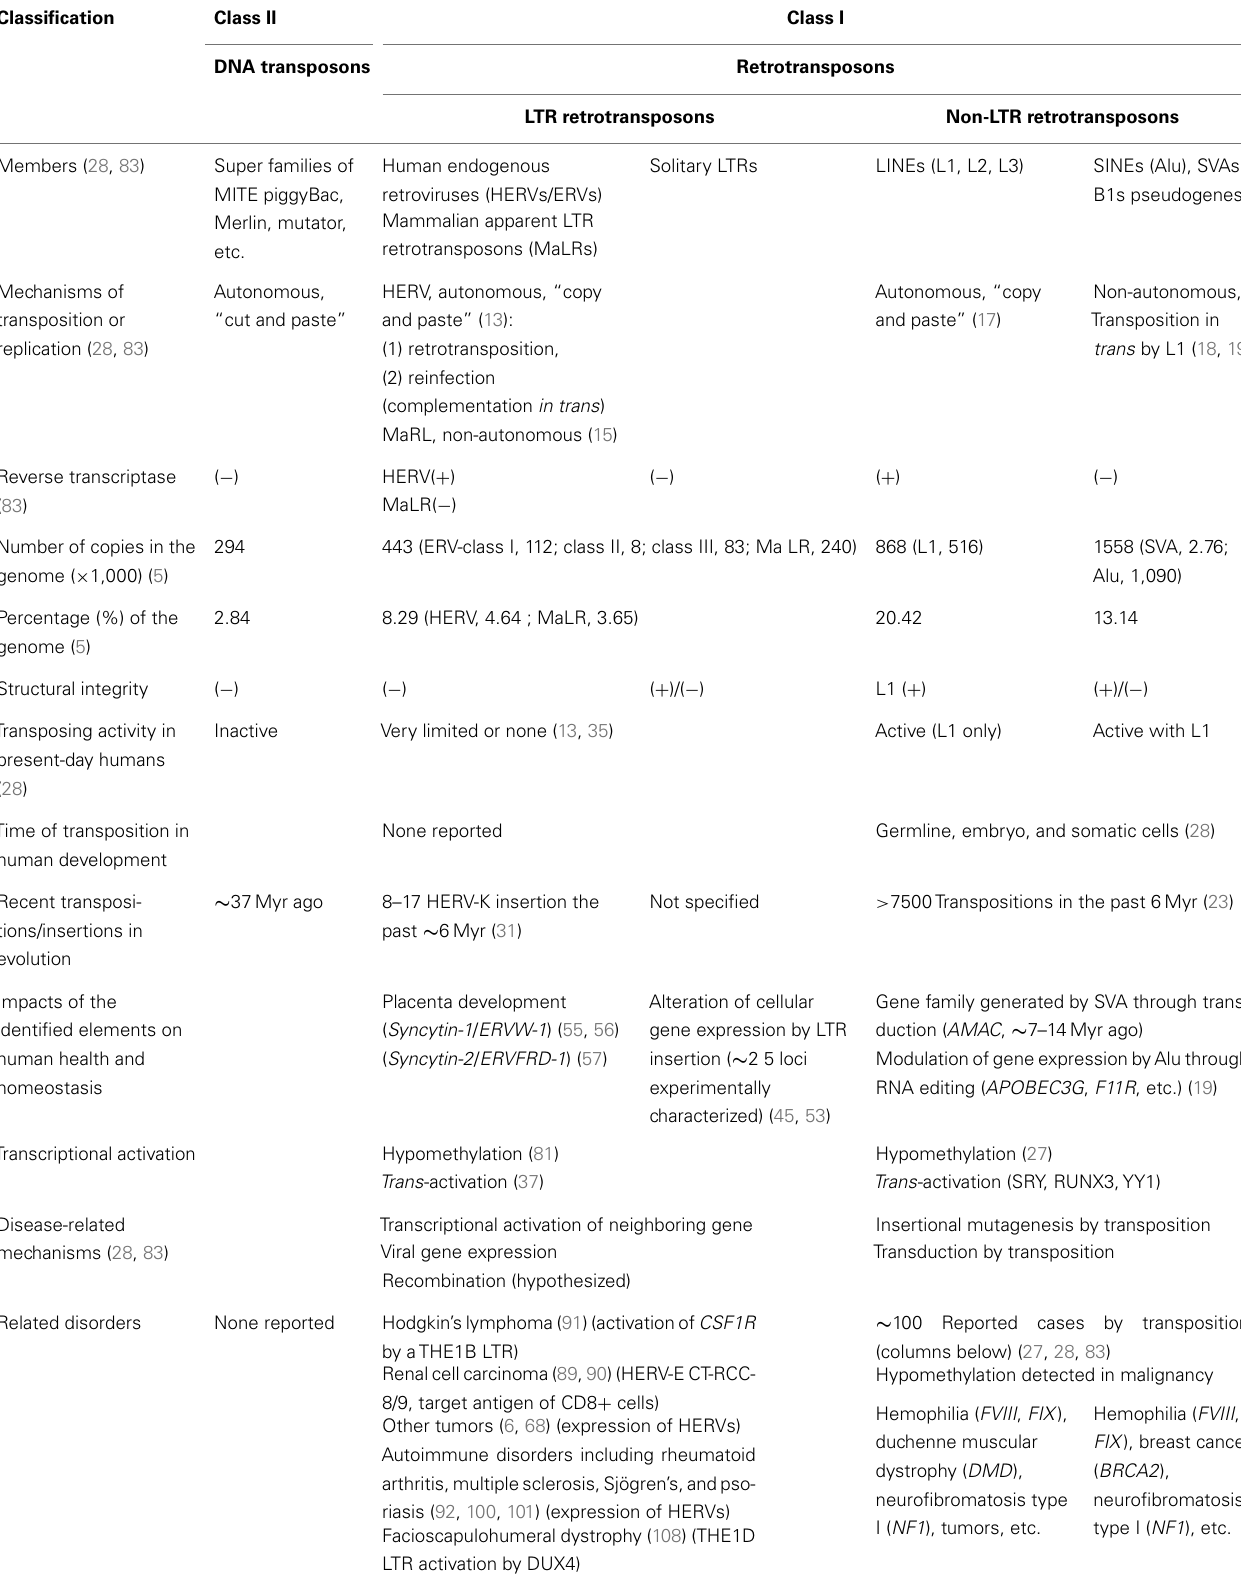
Table 1 |Transposons in the human genome and their influences on health and